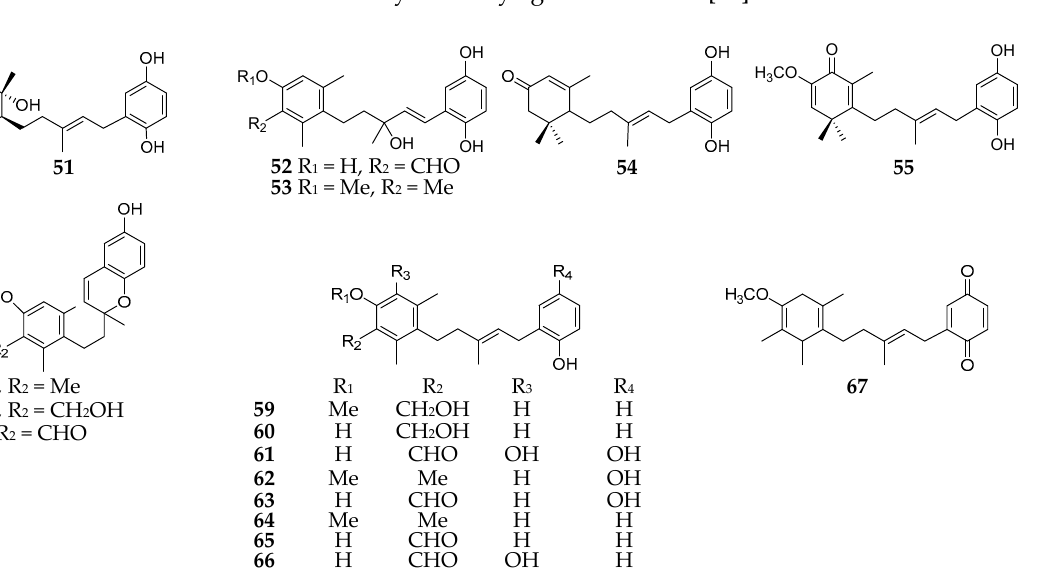
Figure 5. Terpenoids 41 – 50 from the subgenus Reniera.